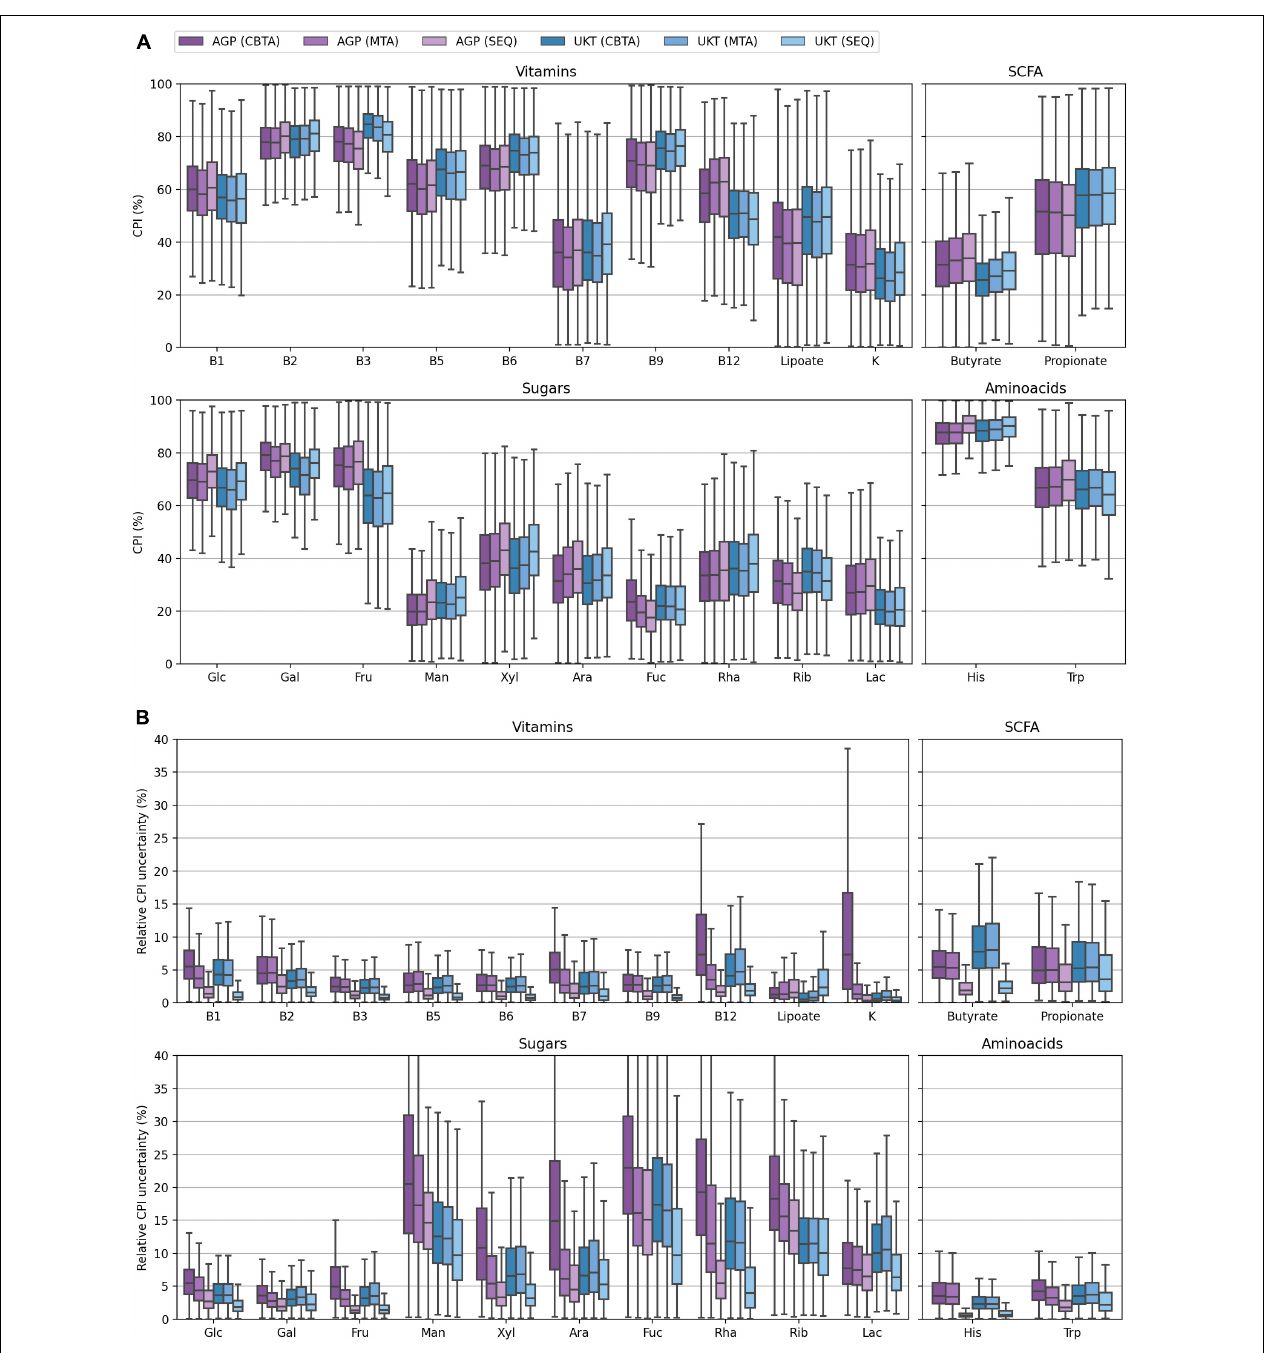
FIGURE 5 | Distributions of CPI values (A) and their relative uncertainty values (B) for the AGP and UKT datasets calculated using three ASV-to-BPM mapping schemes.